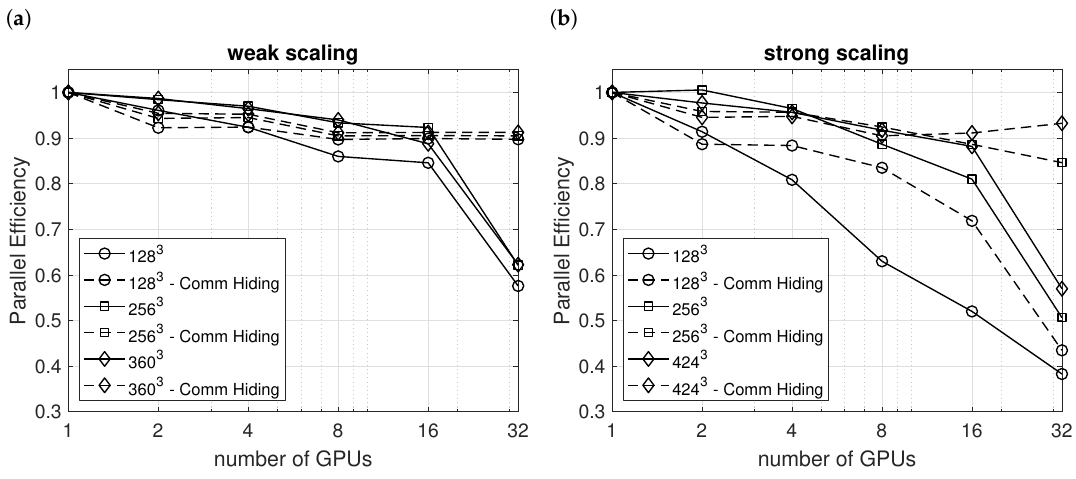
Figure 3. Multi-GPGPU: parallel efficiency for weak scaling ( a ) and strong scaling ( b